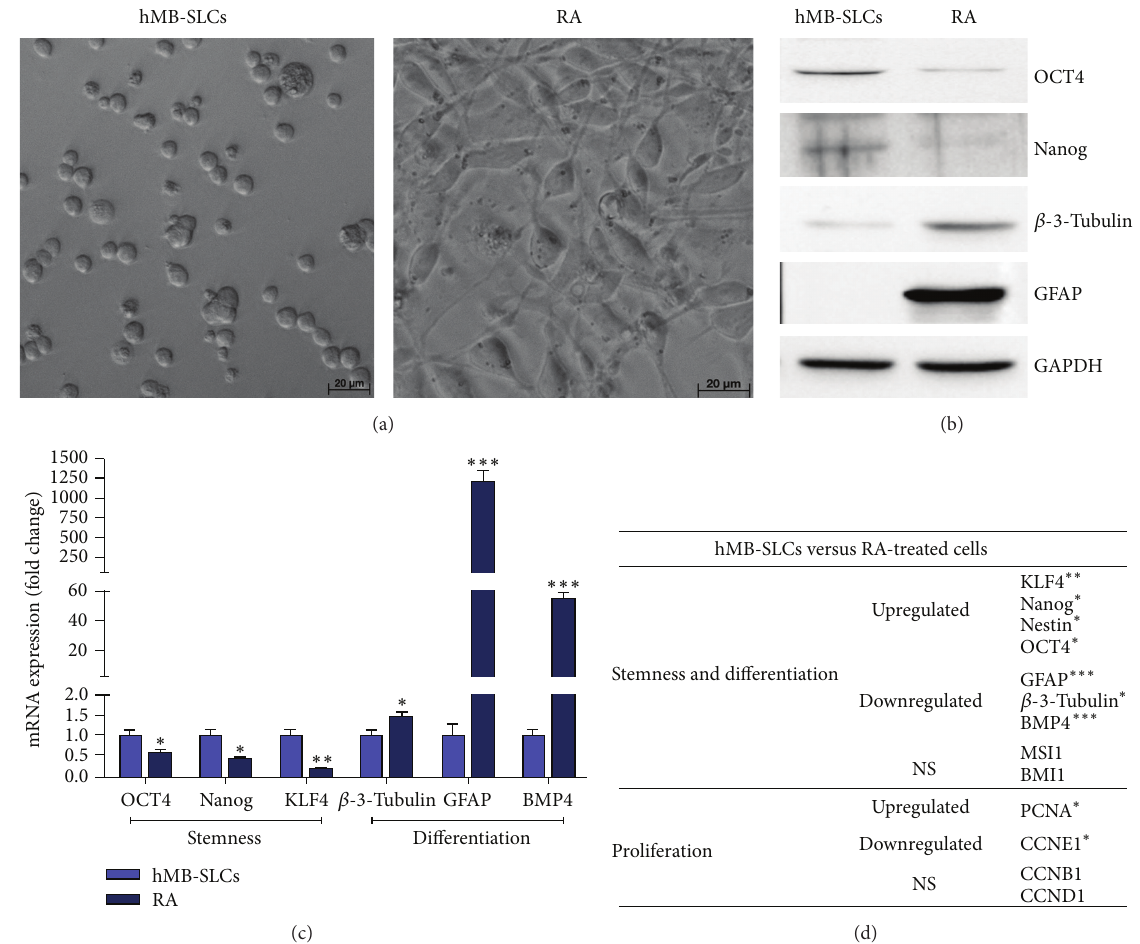
Table 1 in Supplementary Material available online at